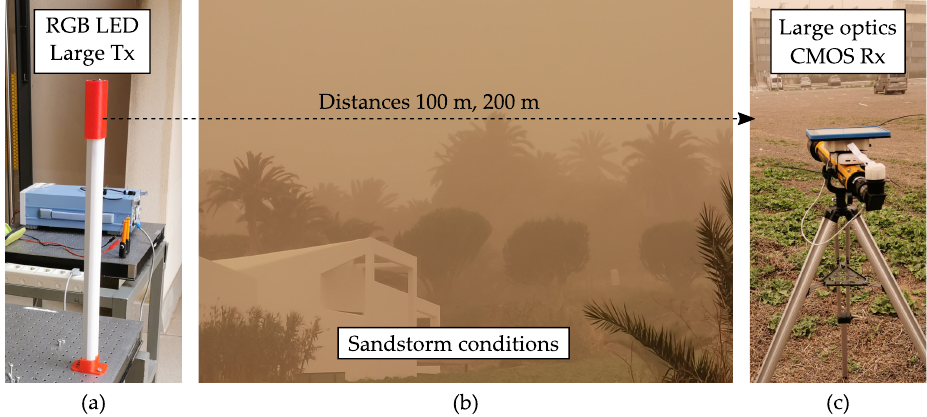
Figure 8. Photographs of the Experiment 3 setup under sandstorm conditions [17]. ( a ) Transmit- ter side using large RGB LED. ( b ) Surroundings of the experiment affected by the sand particles. ( c ) Receiver side using the CMOS camera attached to a telescope.